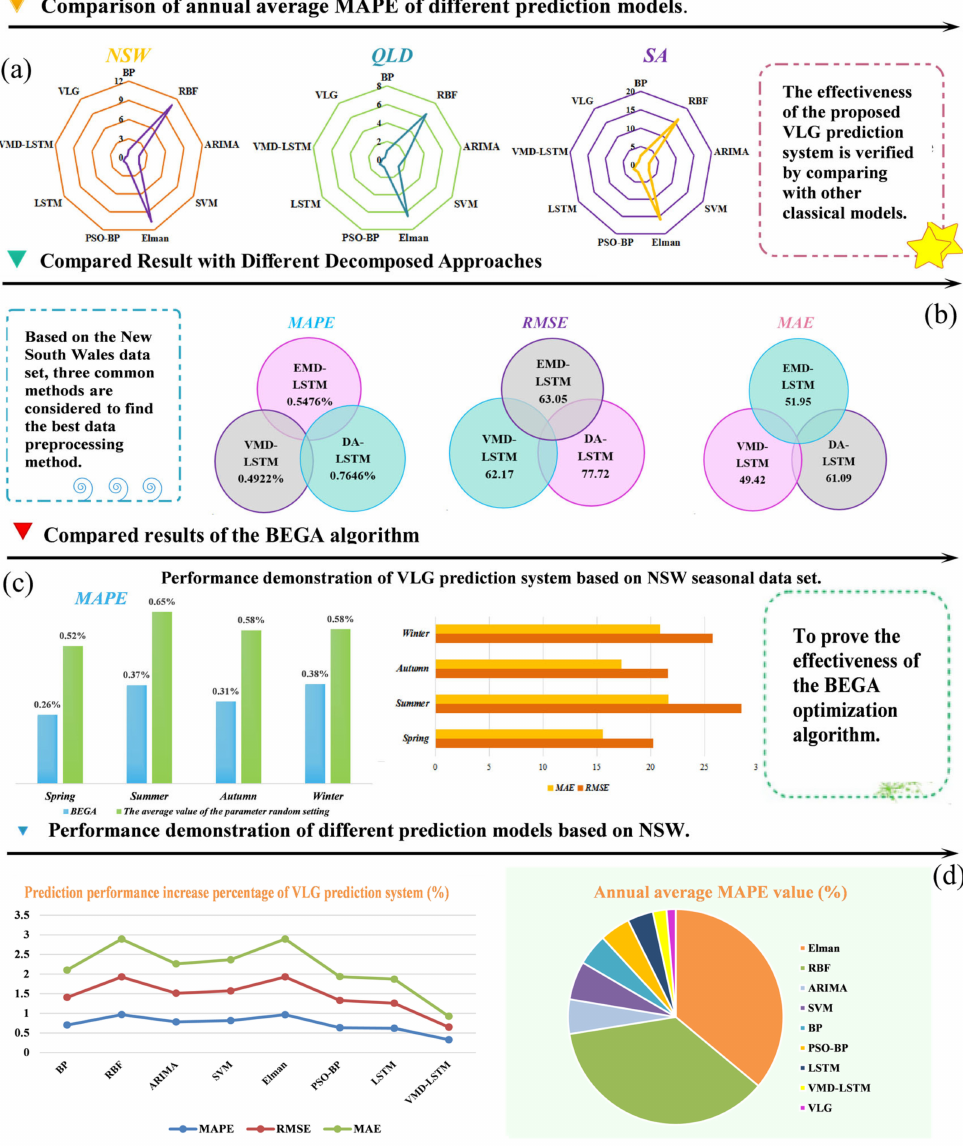
Figure 6. Comparison results of the hybrid forecasting models. ( a ) Comparison of annual average MAPE of di ff erent prediction models. ( b ) Compared results with di ff erent decomposed approaches. ( c ) Compared results of the BEGA algorithm. ( d ) performance demonstration of di ff erent prediction models based on